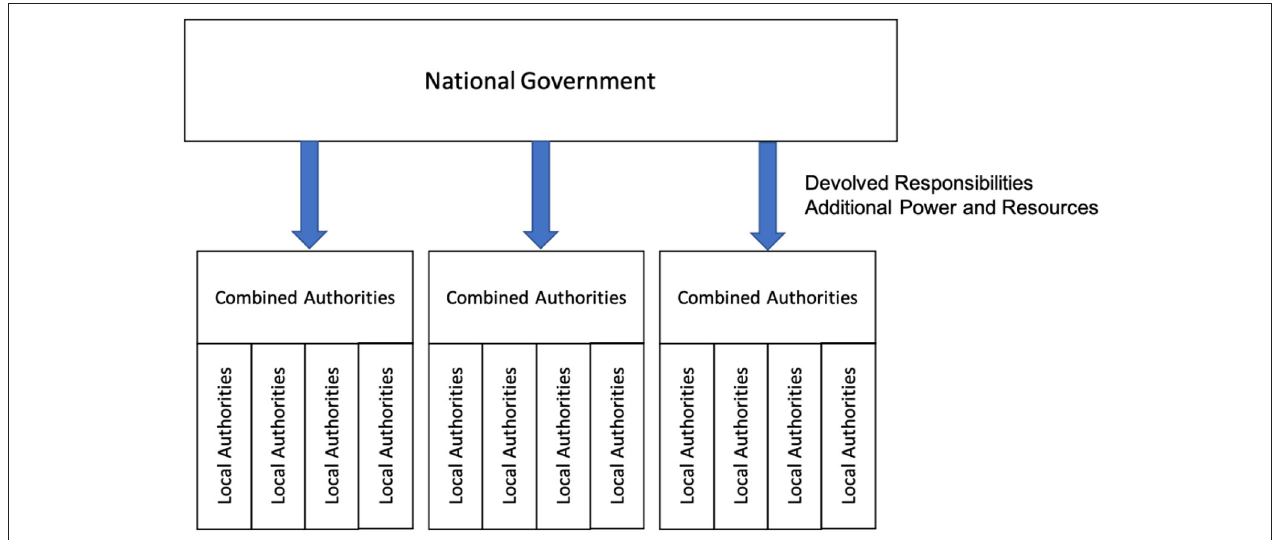
FIGURE 1 | A graphical depiction of the key actors associated with sub-regional devolution, showing the shifting of responsibilities, powers, and funding from central government to devolved combined authorities that are comprised of two or more local